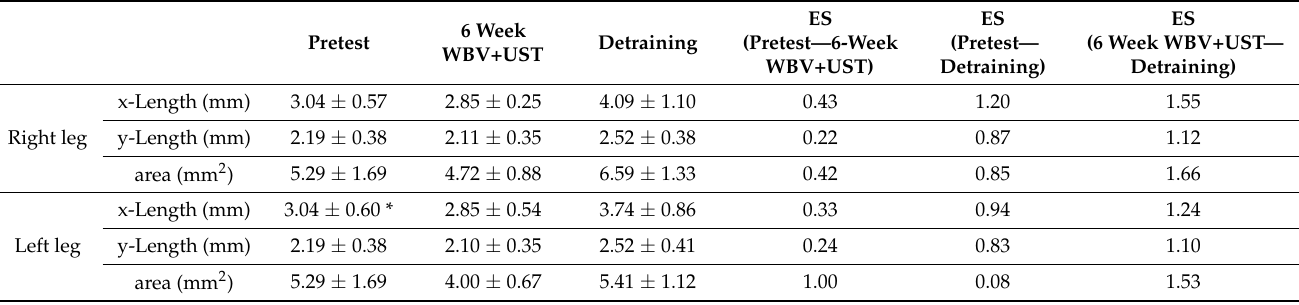
Table 4. Descriptive statistics of center of